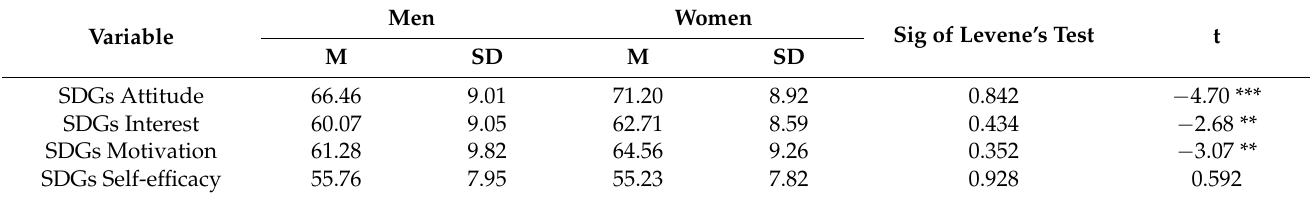
Table 10. Differences among the four subscales of SDGPI by gender.